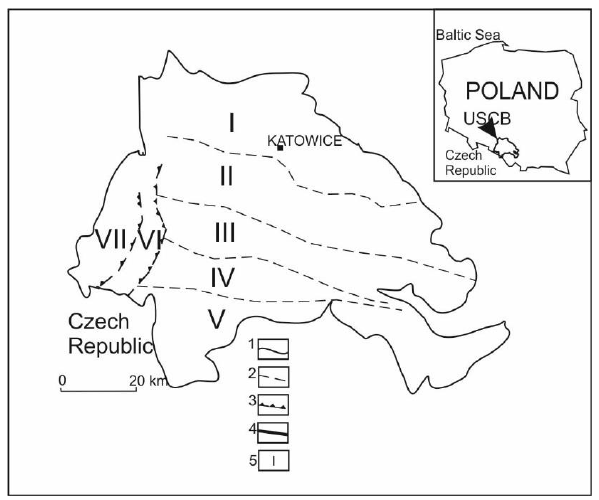
Fig. 3. Division of the USCB into seven gassy regions (modified after Kotarba et al., 1995) 1 – the USCB boundary, 2 – main faults, 3 – overthrusts, 4 – the regions boundaries, 5 – region